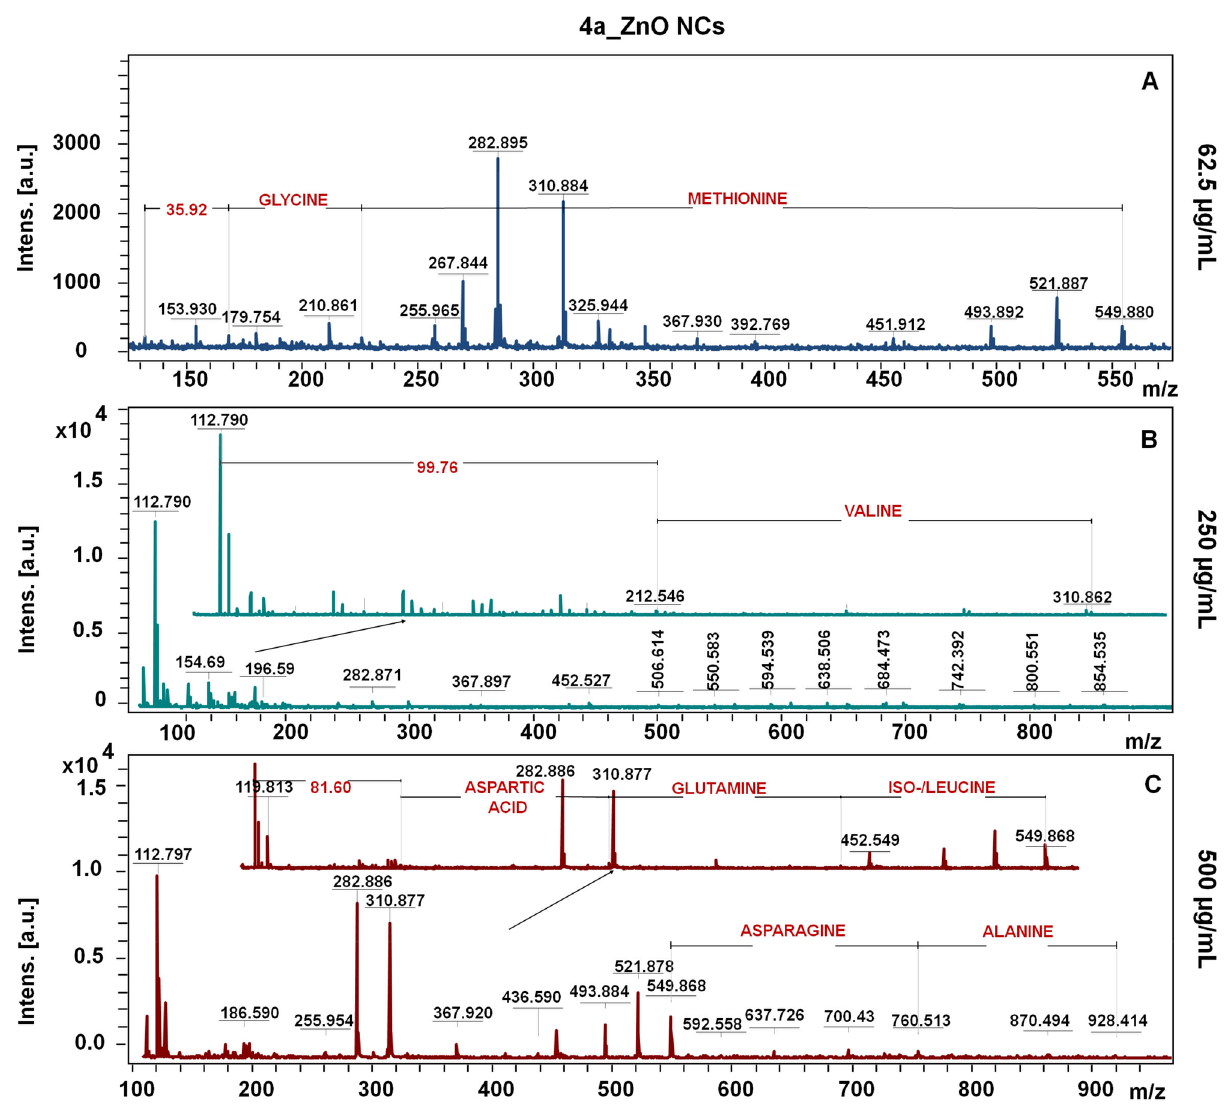
Figure 7. The LDI-TOF-MS spectra for core–shell signals of 4a_ZnO NCs at 62.6 ( A ), 250 ( B ) and 500 ( C ) µg/ mL